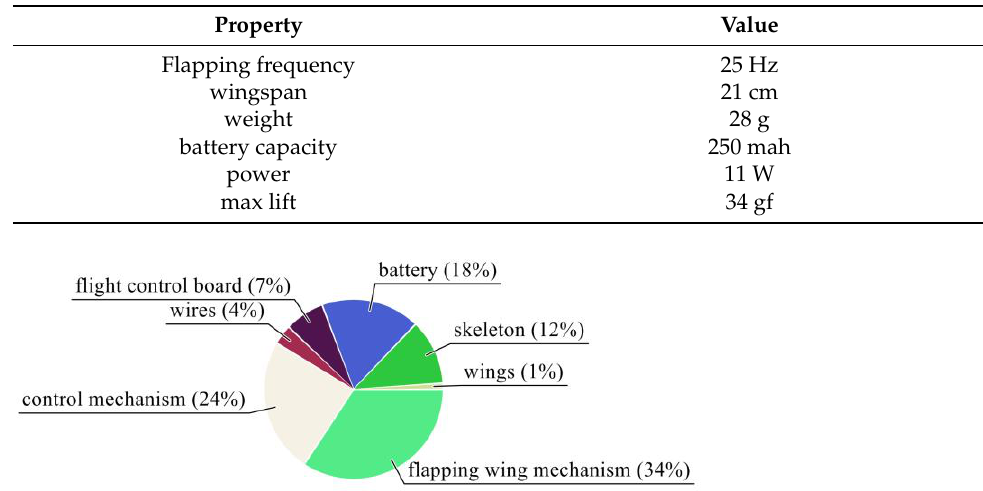
Figure 10. The physical drawing of the prototype. Table 2. The main properties of the FMAV prototype.